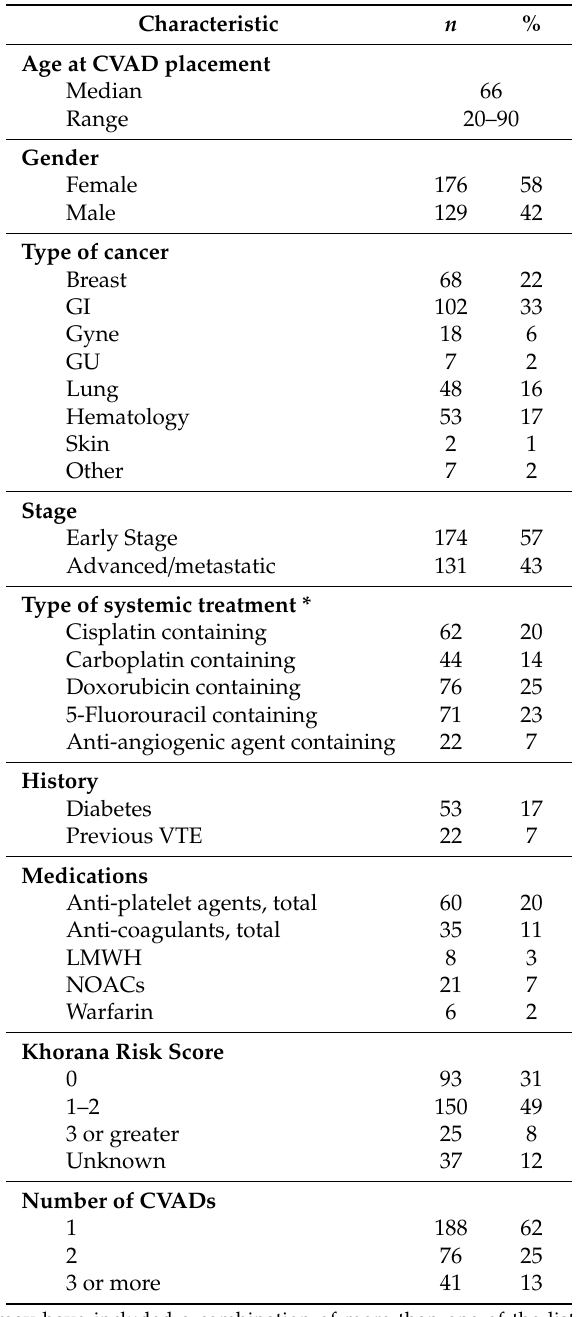
Table 1. Patient characteristics ( n =